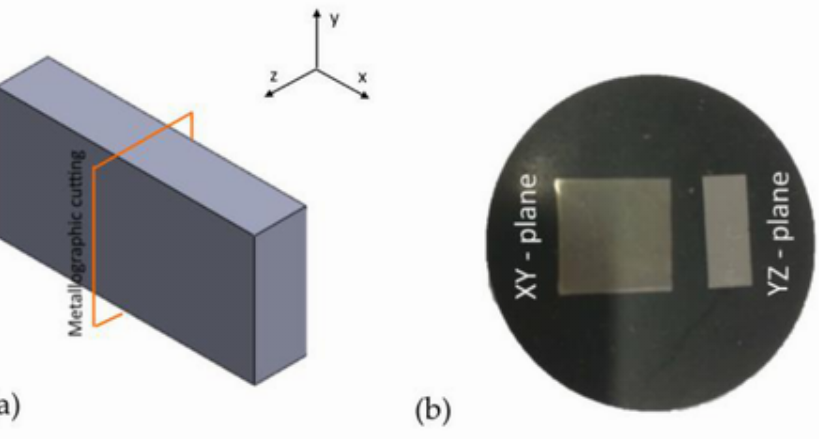
Figure 1. Schematic representation of the sample preparation. ( a ) Sample orientation and cutting plane, ( b ) resulting metallographic